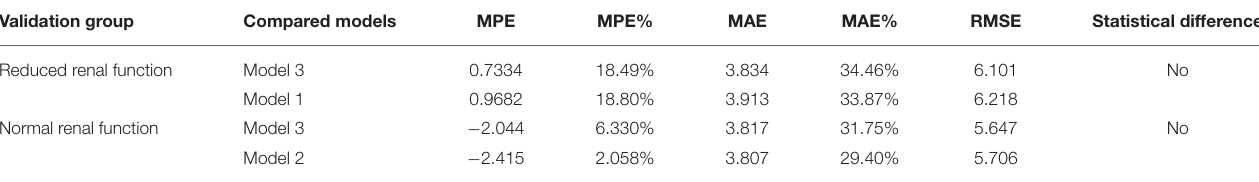
TABLE 9 | The MPE, MPE%, MAE%, and RMSE values of the external validation. Validation group Reduced renal